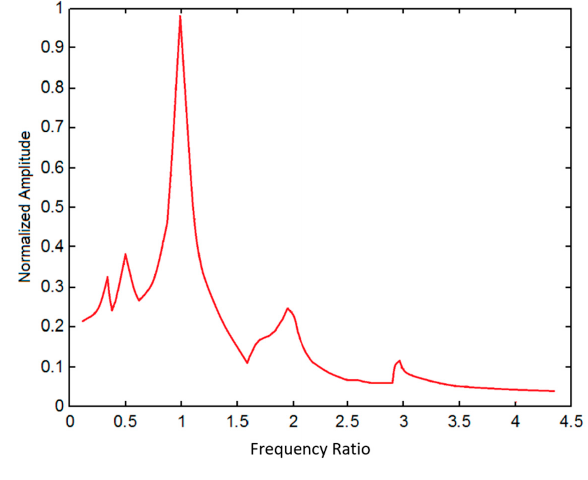
k d = 4,(cid:2022) = 0.05) . = 4, ξ = 0.05 ) (cid:3038) (cid:3291) k p